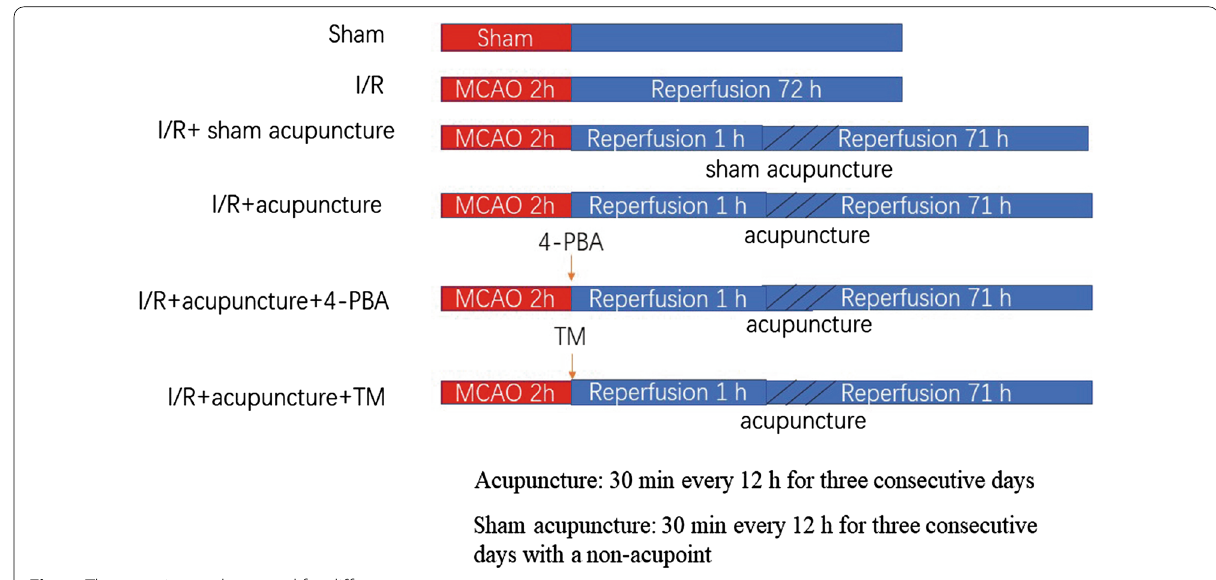
Fig. 1 The experimental protocol for different